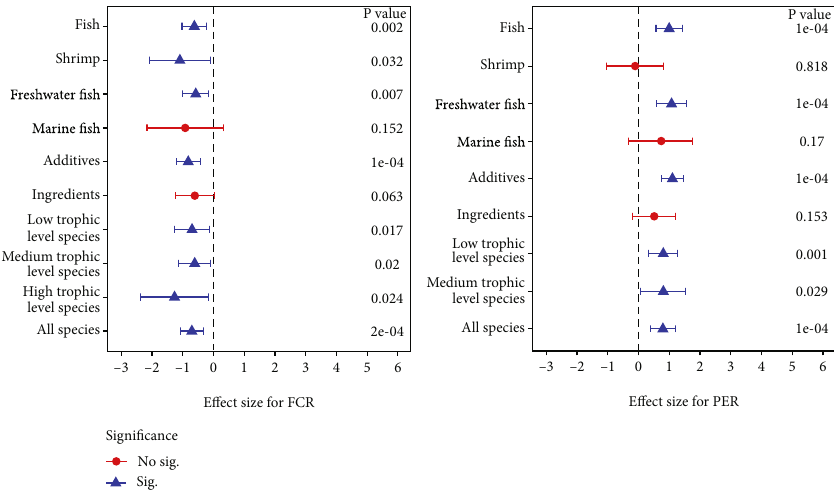
Figure 5: Hedges ’ g comparisons for FCR and PER ( mean ± 95 % CI) subgroup analysis (random-e ff ects model). The con fi dence interval intersecting with the dashed line indicated no signi fi cant di ff erences between the control group and treatment group, and vice versa.